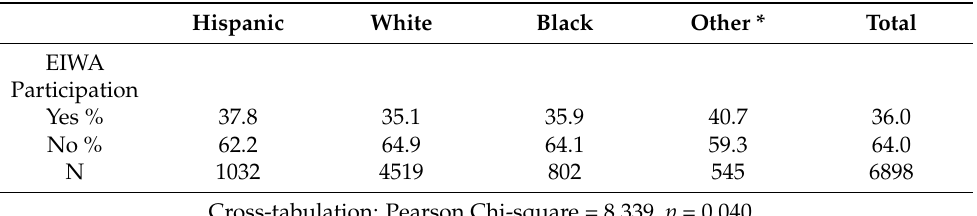
Table 2. EIWA Participation Rates by Race/Ethnicity.